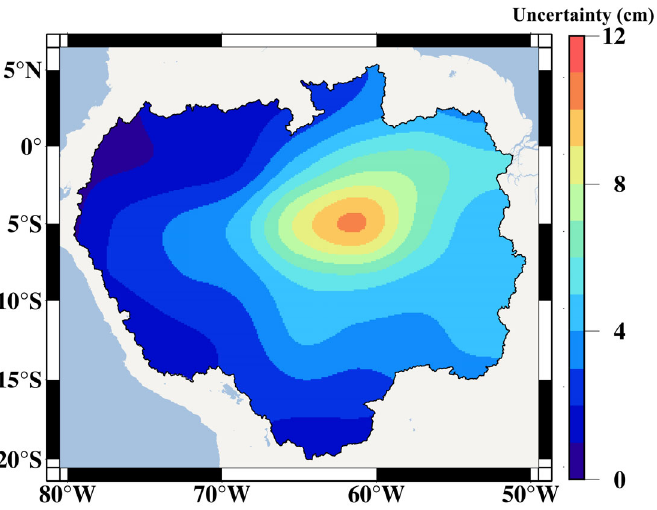
Figure 4. The spatial distribution of uncertainties of TWSC from fused results.